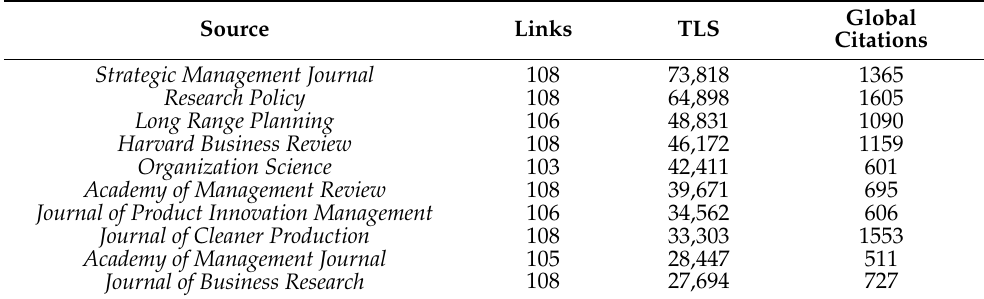
Table A6. Structural bibliometric indicators for the top ten sources included in the co-citation network (ranked by